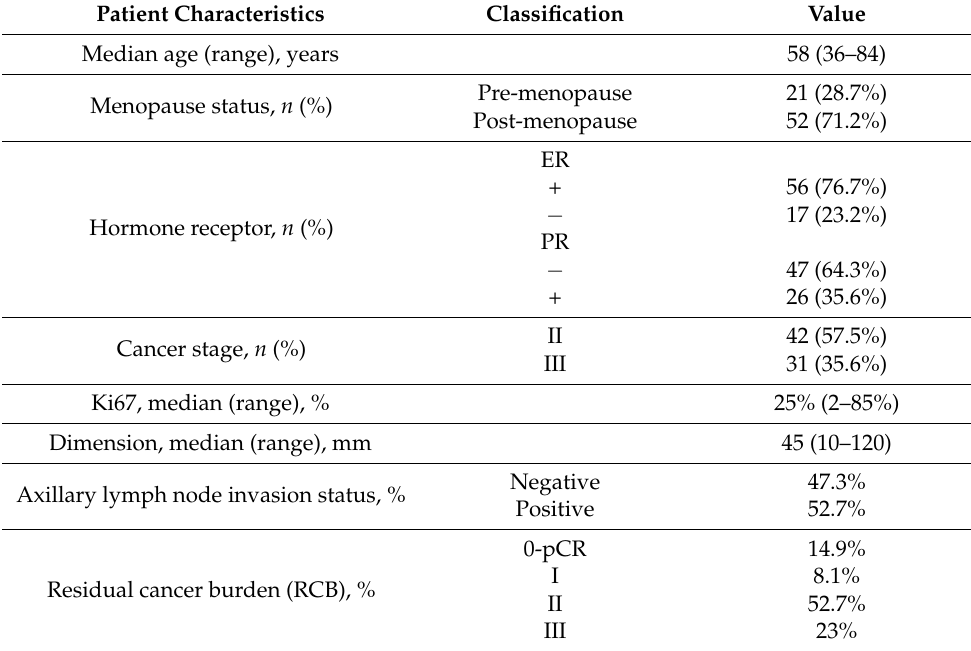
Table 1. Patient demographic and primary invasive tumor